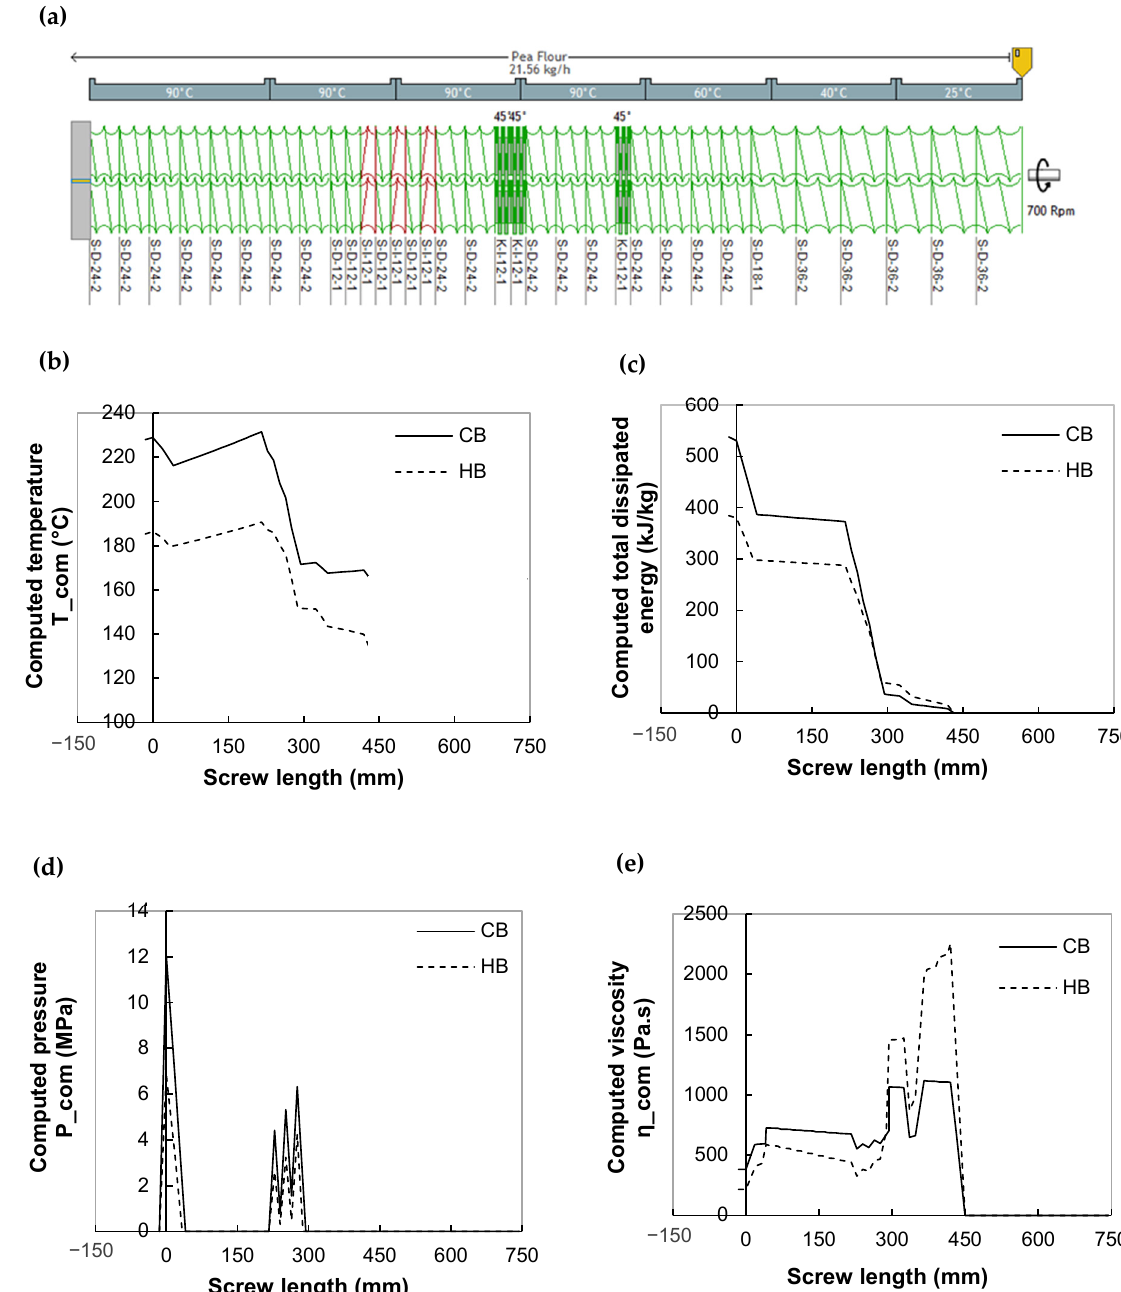
Figure 2. Profiles of screw ( a ) and computed flow variables along the screws for breakfast cereals Figure 2. (CB -) and (HB,--): ( b ) product temperature, ( c ) total dissipated energy, ( d ) pressure, and ( e ) viscosity. Processing conditions: flow rate Q = 20 kg/h, screw speed N = 500 rpm, moisture content MC = 15% and barrel temperature profile: 20, 40, 60, 90, 90, 90, 90 ◦